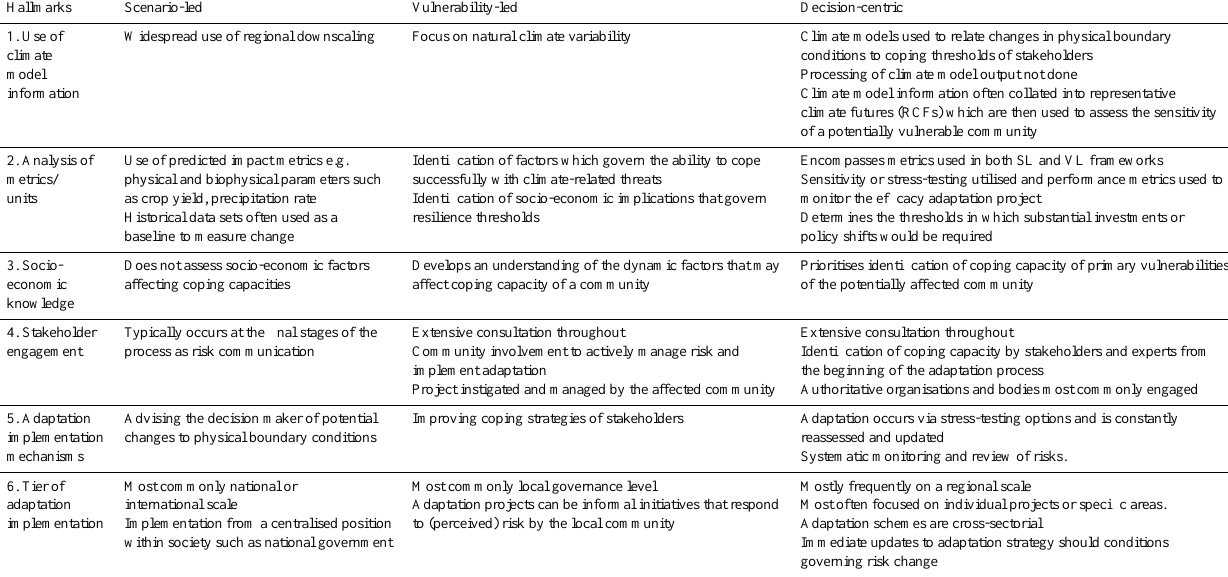
Table A1. Criteria defining the hallmarks of each adaptation framework.